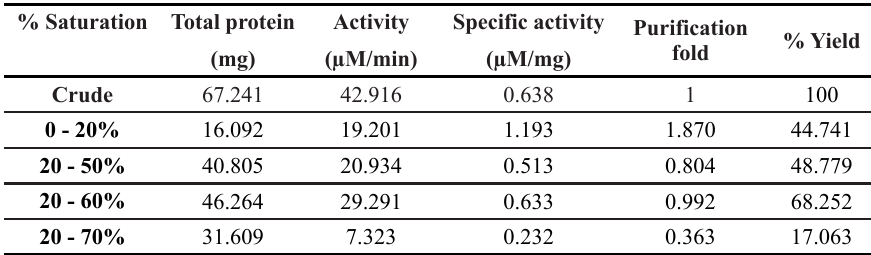
Table 1: Summary of ammonium sulphate precipitation of C. lanatus rind invertase % Saturation Total protein